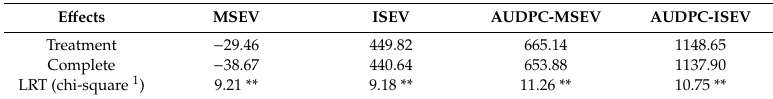
Table 2. Summary of analysis of deviance (ANADEV) for leaf spots resistance evaluation as severity means (MSEV) and severity index at 138 days (ISEV); area under disease progress curve for the means (AUDPC-MSEV) and severity index